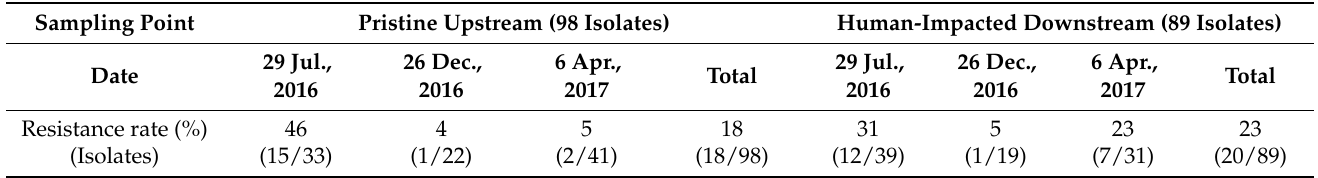
Table 2. Antibiotic resistance rate of E. coli during survey